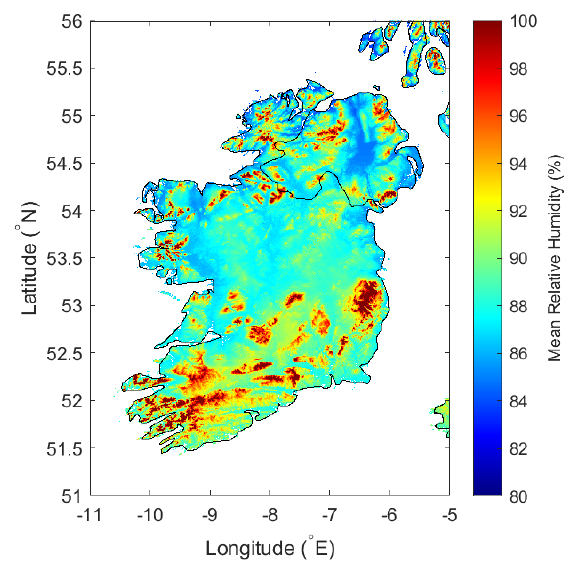
Figure 29. A mean relative humidity map of the island of Ireland, generated using Equation (8), using topographical data obtained from NASA and processed with the READHGT function